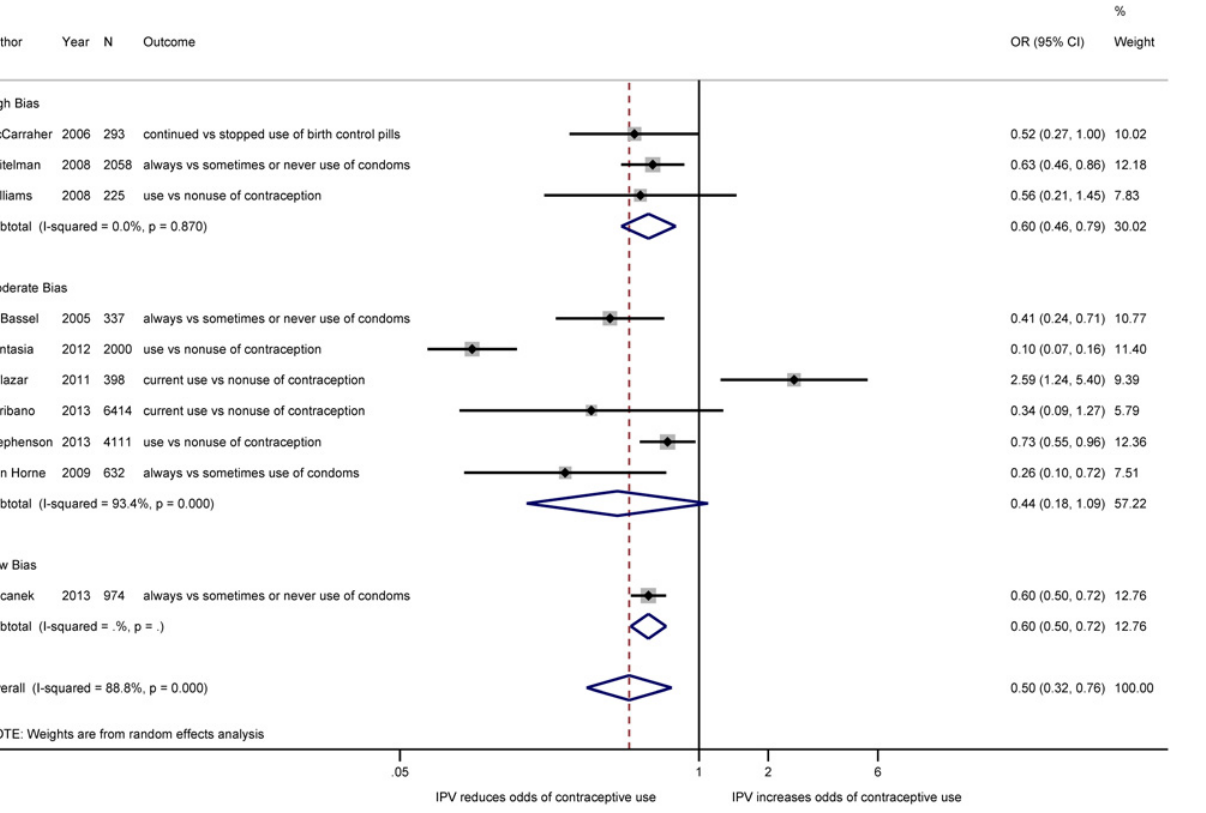
Fig 3. Meta-analysis of the association between IPV and contraceptive use, by level of bias. Estimated effect measures from the Fantasia, McCarraher, Kacanek, Teitelman, Van Horne, and Williams studies have been inverted to present estimates of contraceptive use rather than non-use.